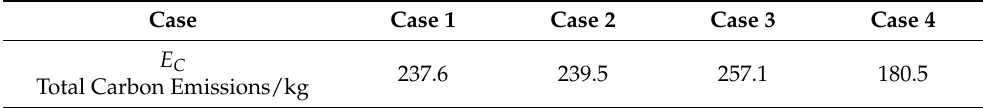
Table 7. Total carbon emissions in the four